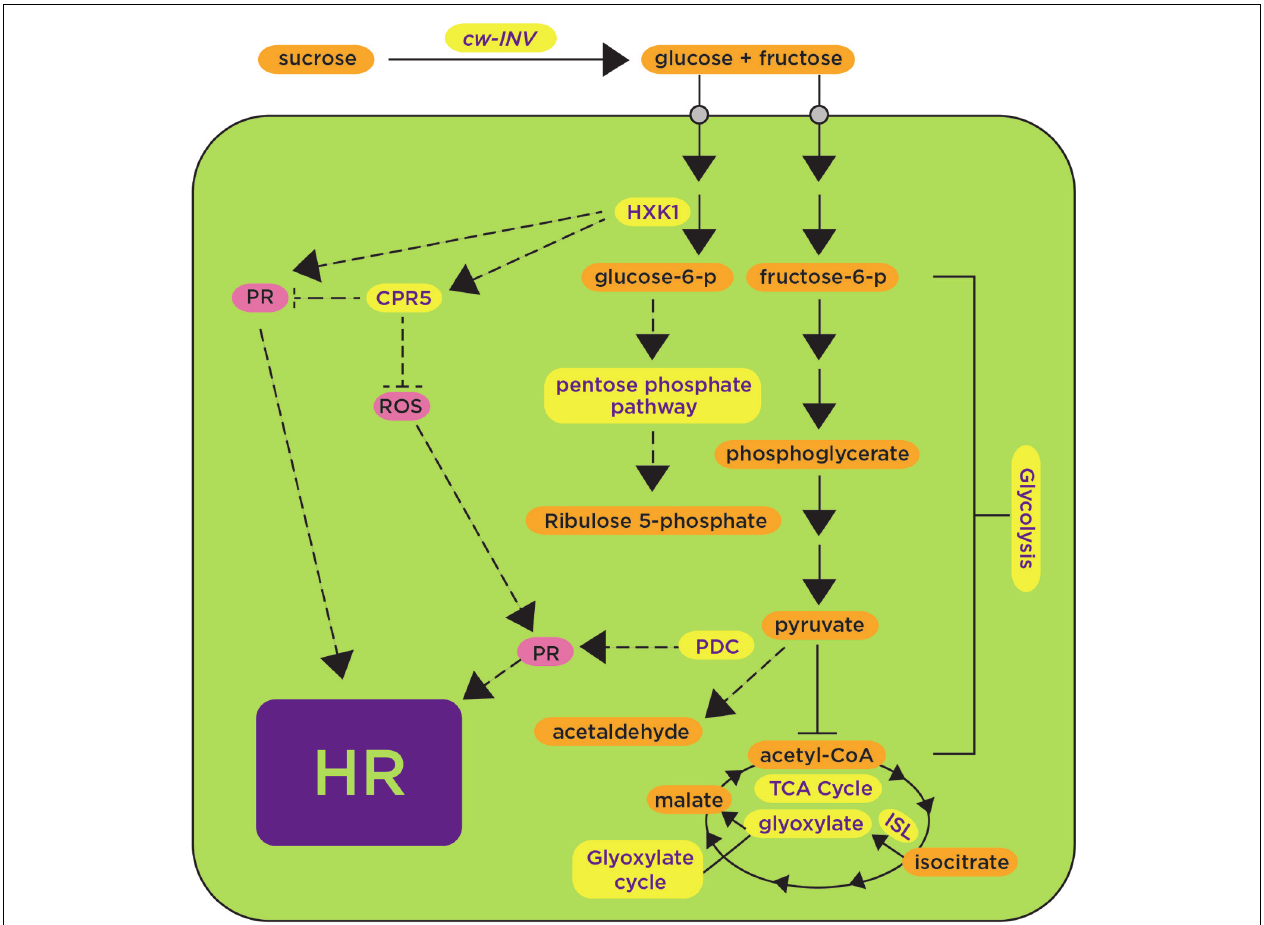
highlighted as components proposed to play a positive (arrows) or negative (blunt-ended lines) role in regulating known defense responses (shown in pink) such as the generation of reactive oxygen species (ROS) and the activation of pathogenesis-related proteins (PR) leading to the hypersensitive response (HR). HXK, hexokinase; CPR5, constitutive expresser of PR genes 5; PDC, pyruvate decarboxylase; ISL, isocitrate lyase. Dashed lines represent hypothetical regulatory